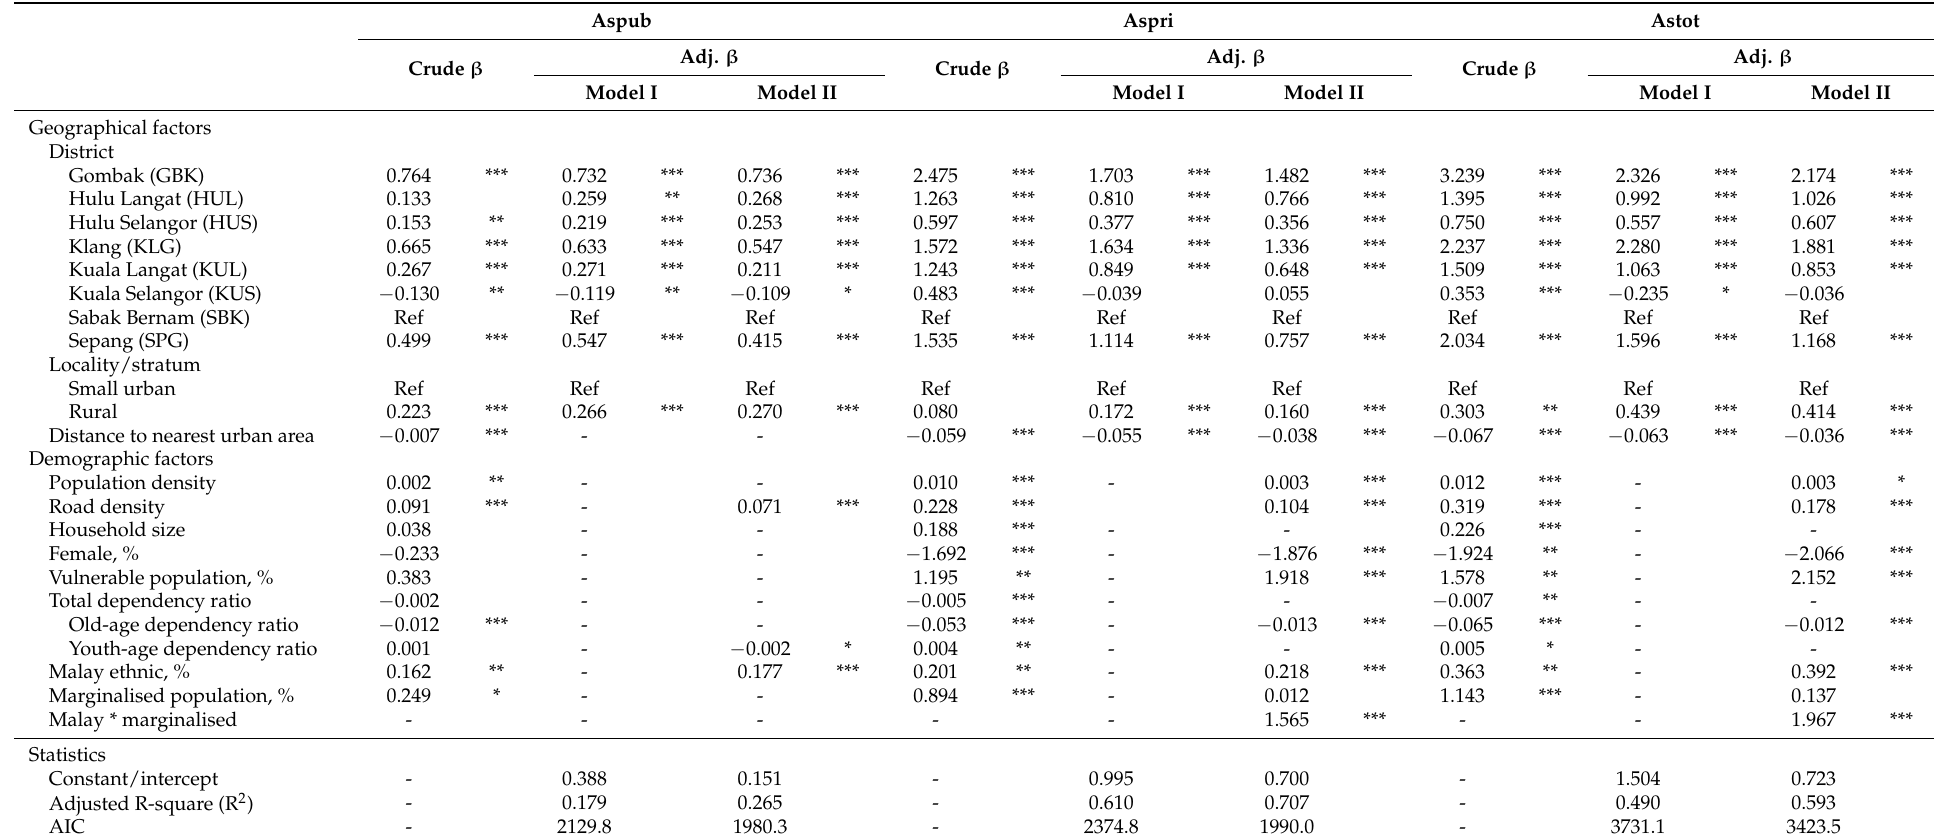
Table 2. Association of geographical and demographic factors with E2SFCA